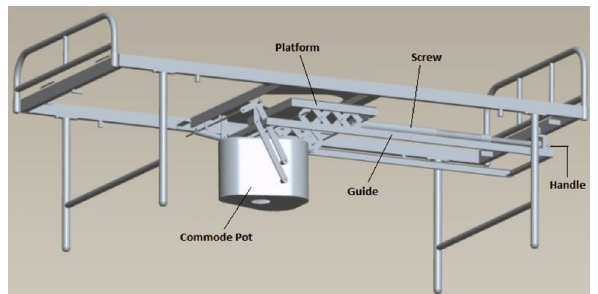
Fig. 1 Bed with commode [33]